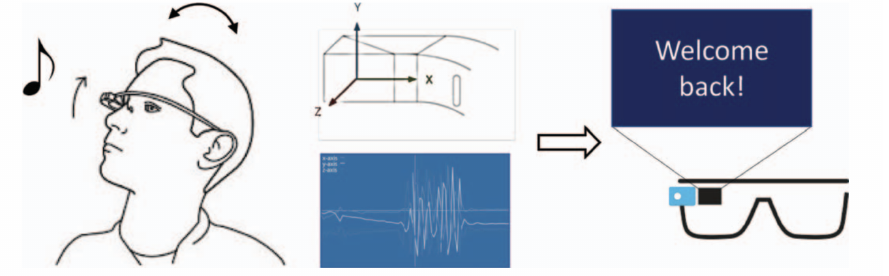
Figure 2. A biometric authentication system based off of head movement and auditory response, as presented in